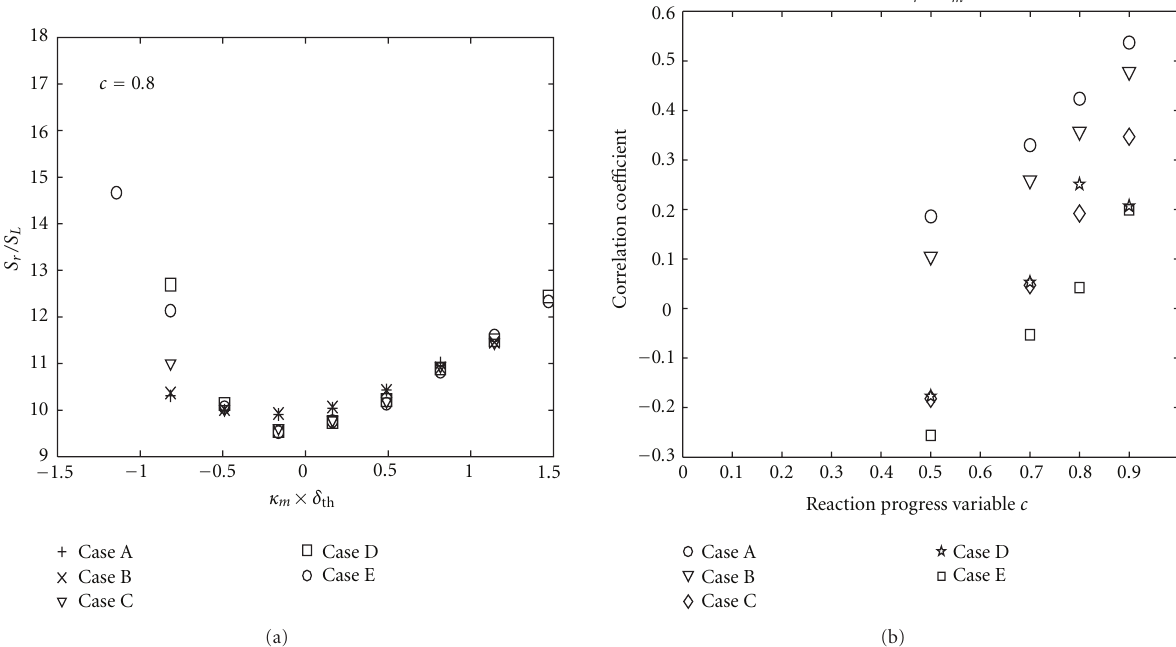
weak, as indicated by the correlation coe ffi cients plotted